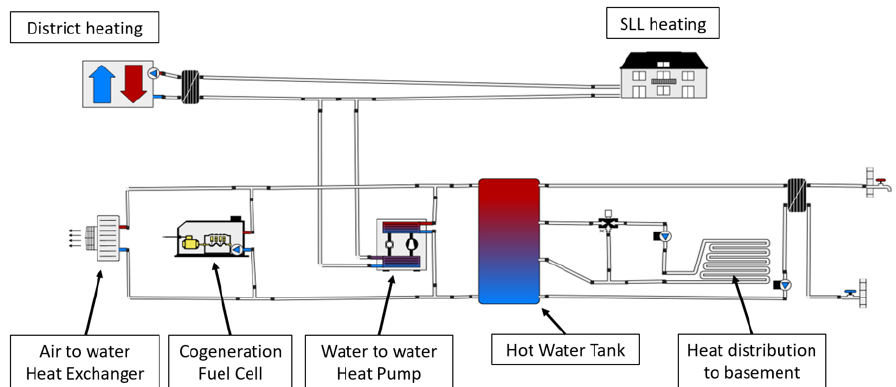
Figure 2. Schematic design of the fuel cell in the heating